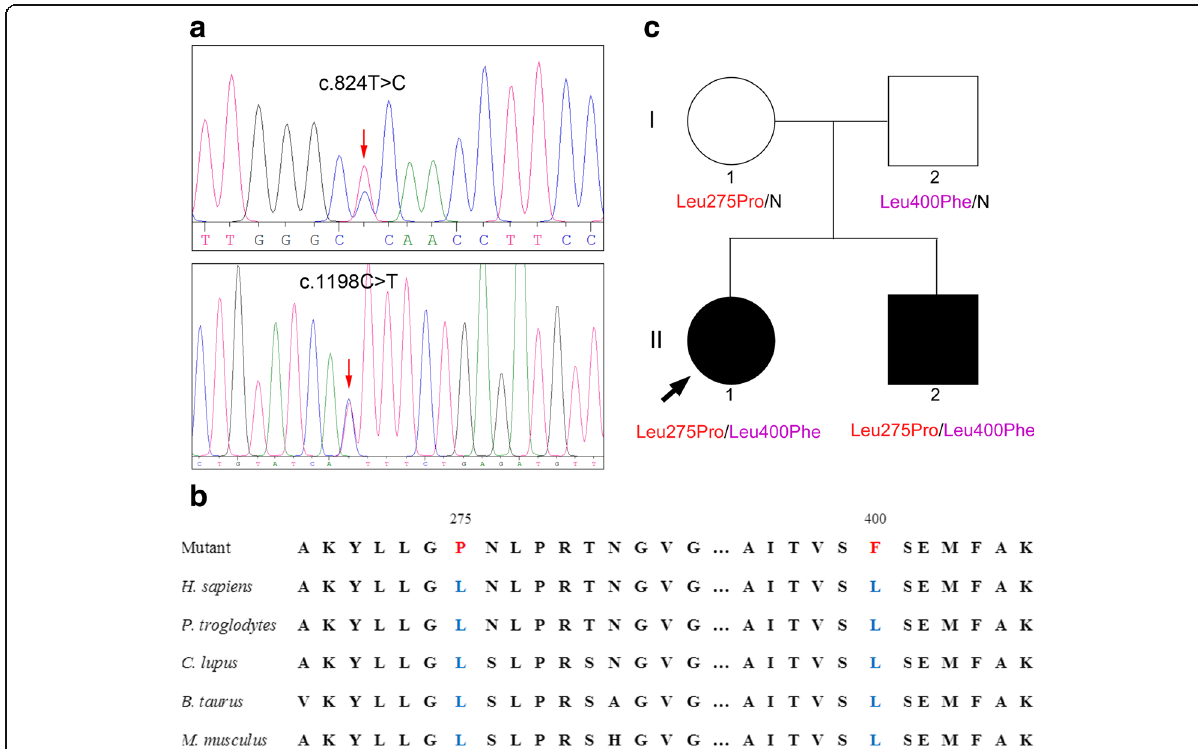
Fig. 3 The missense mutations in SLC26A2 in patient 1 and family pedigree. Sanger sequencing results revealed novel compound heterozygous mutations ( a ) in SLC26A2 contributing to MED-4 ( c ). Both of these mutations are evolutionarily conserved ( b )